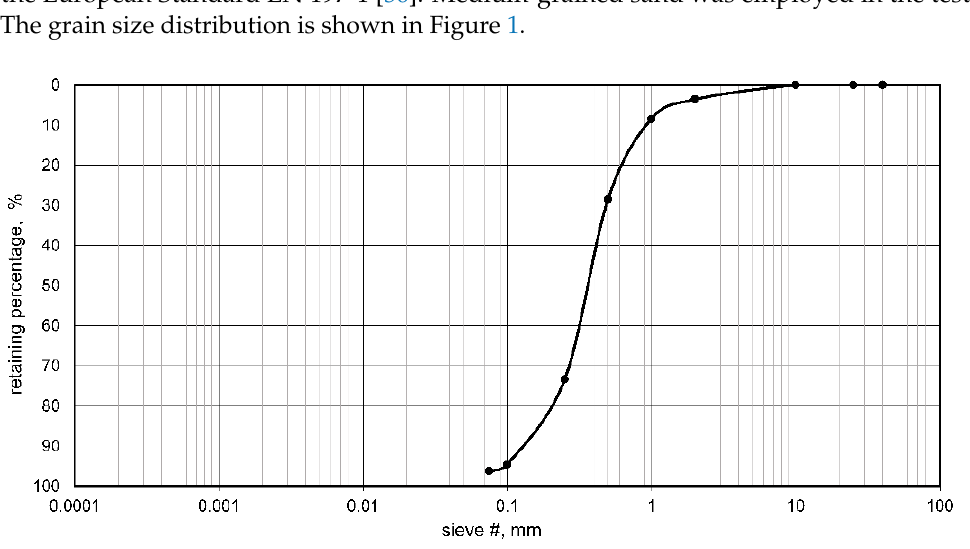
Figure 1. Gradation curve of the sand used in this